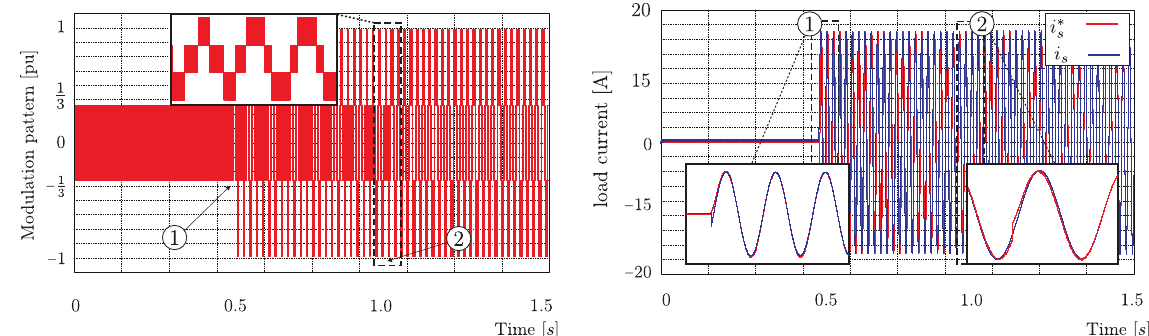
Figure 10. Simulation results: transient performance of the PMR current controller. (1) Reference step change from 0 to 1pu at t = 0.5s. (2) Load impact of 100% at t =